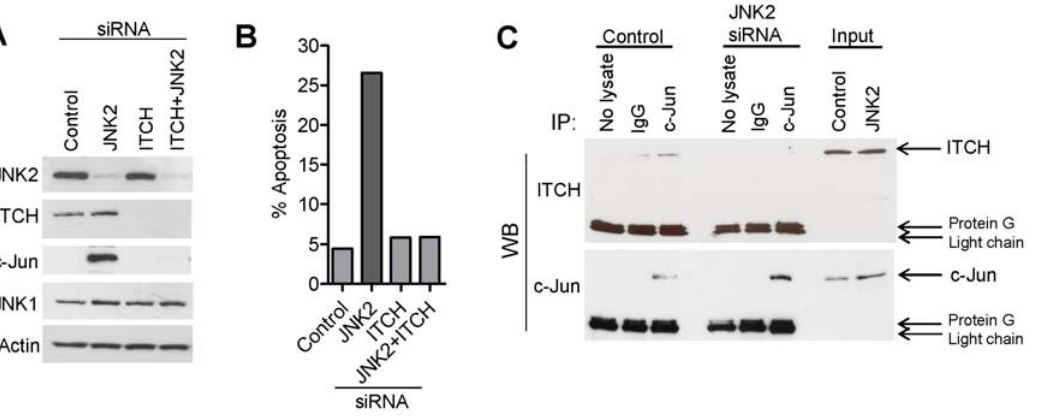
Figure 5. c-Jun is complexed with ITCH under basal condition and released following JNK2 silencing. (A) and (B) Protein and apoptotic levels observed following ITCH and JNK2 silencing in HCT116 cells. (C) Complexes of endogenous ITCH-c-Jun proteins detected prior to JNK2 silencing are lost following JNK2 depletion.